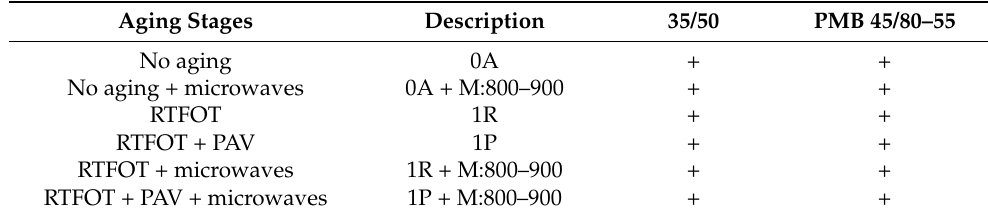
Table 7. Aging plan for tested bitumen